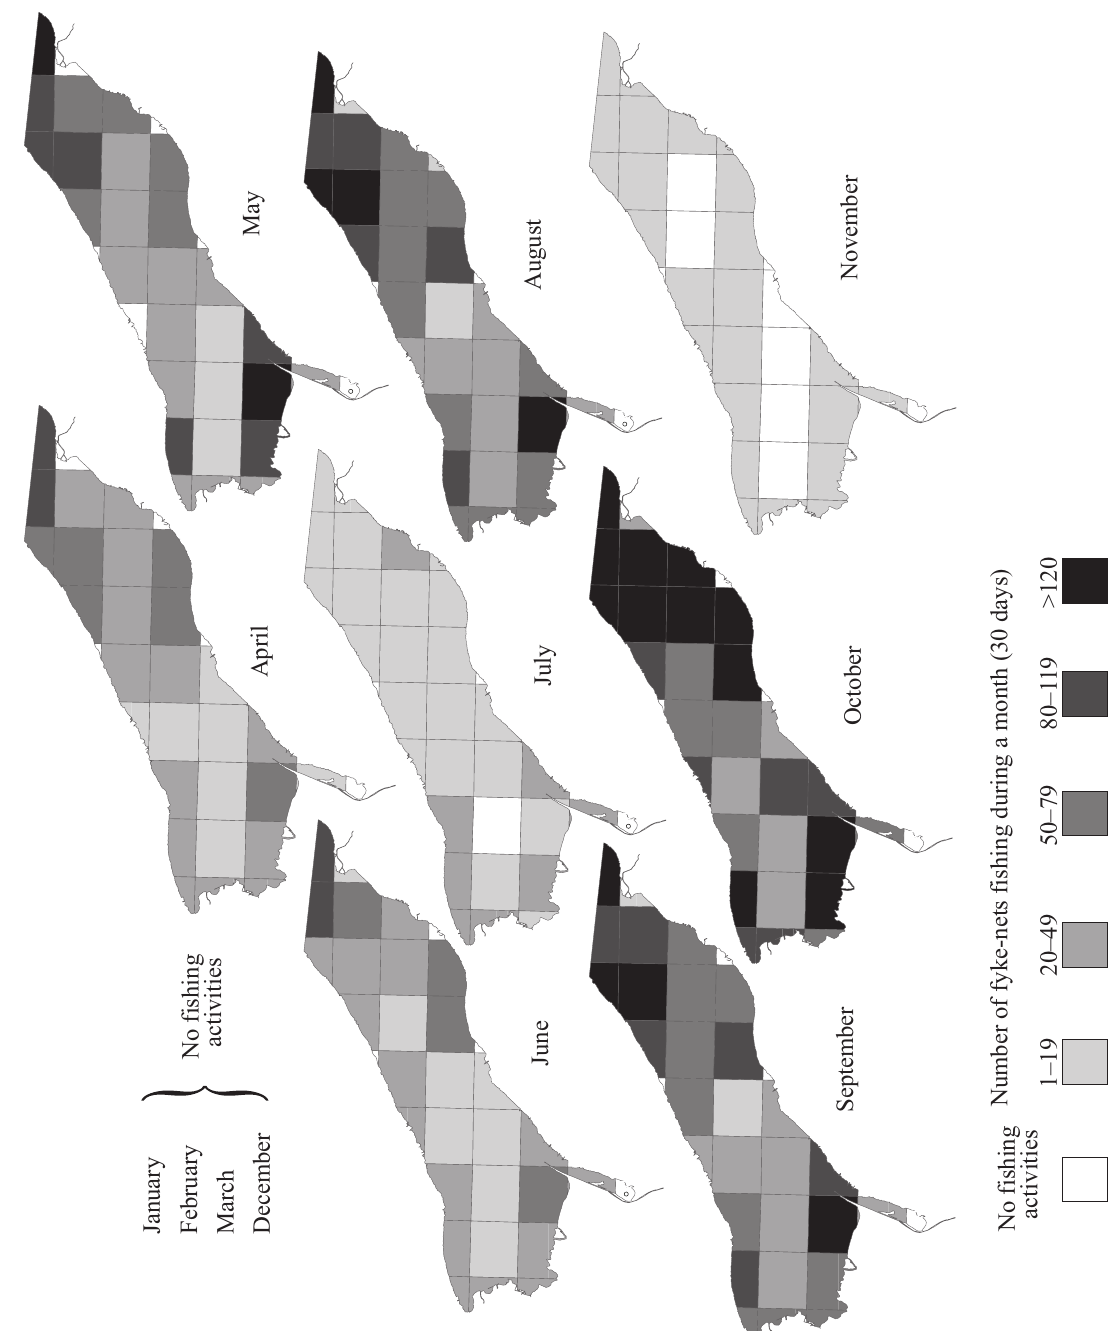
Fig. 4. Distribution of fyke nets in the lagoon in subsequent months of